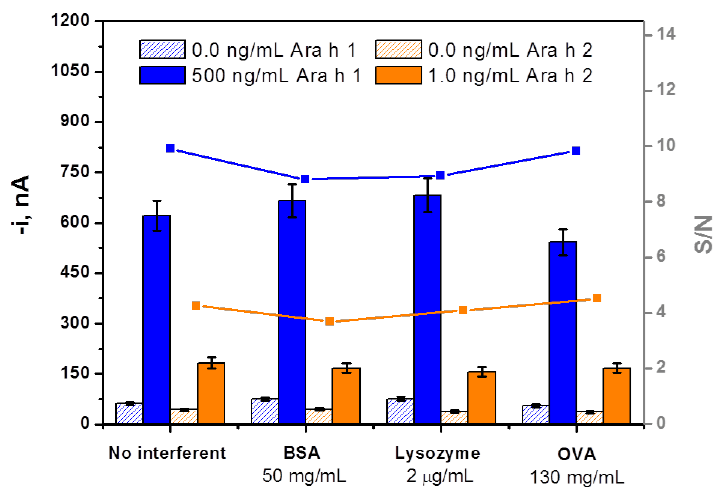
Figure 4. Current values measured for 0 and 500 ng/mL Ara h 1 and 0 and 1.0 ng/mL Ara h 2 in the absence or in the presence of 50 mg/mL bovine serum albumin (BSA), 2 μg/mL lysozyme and 130 mg/mL ovalbumin (OVA). Supporting electrolyte, 0.05 M sodium phosphate solution, pH 6.0; E app = −0.20 V vs. Ag pseudo-reference electrode. Error bars estimated as triple of the standard deviation ( n = 3).